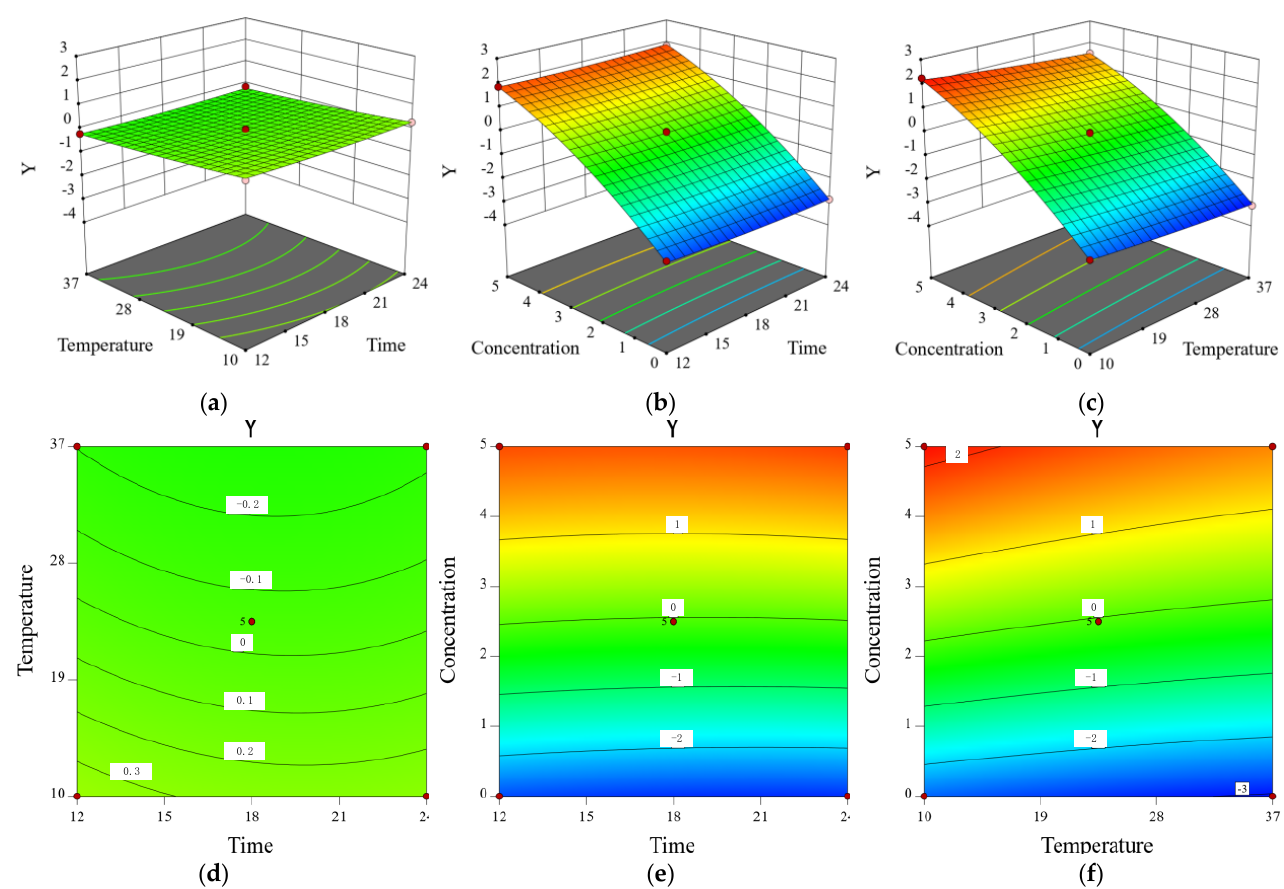
Molecules 2021 , 26 , x FOR PEER REVIEW 10 of 15 The 3D response surface plot and contour plot (Figures 7 and 8) intuitively displayed